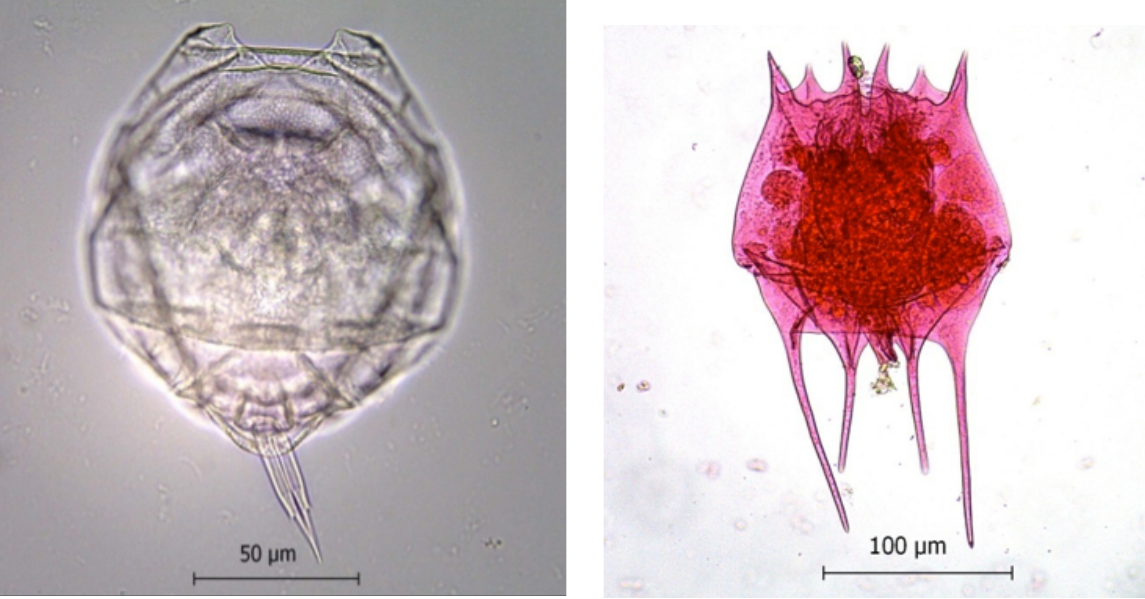
Image 3. Brachionus mirabilis Daday, ventral